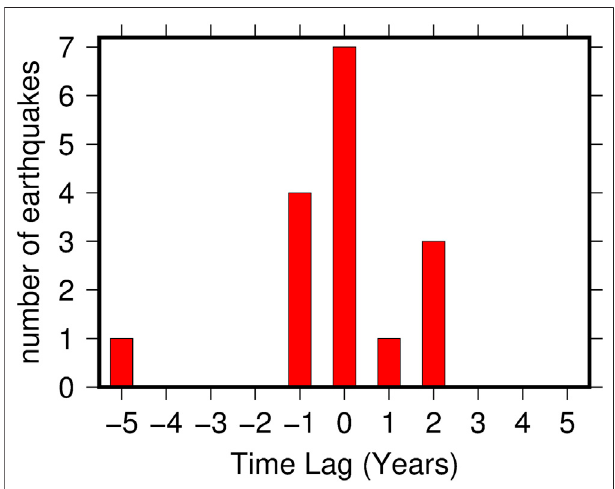
FIGURE 6 | Earthquakes with M ≥ 4.8 occurred between 1934 and 2012 classi fi ed according to the time lag computed for the nearest sc-PDSI peak in Figure 5B